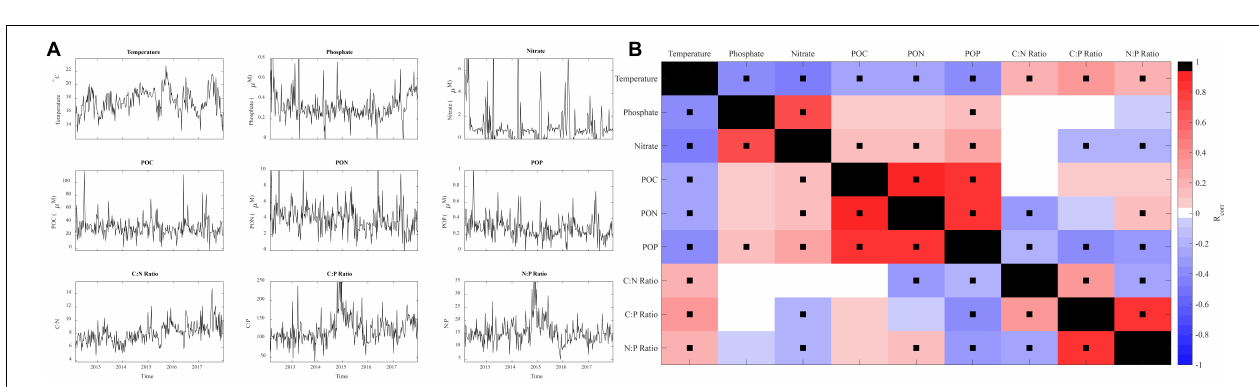
Frontiers in Marine Science |